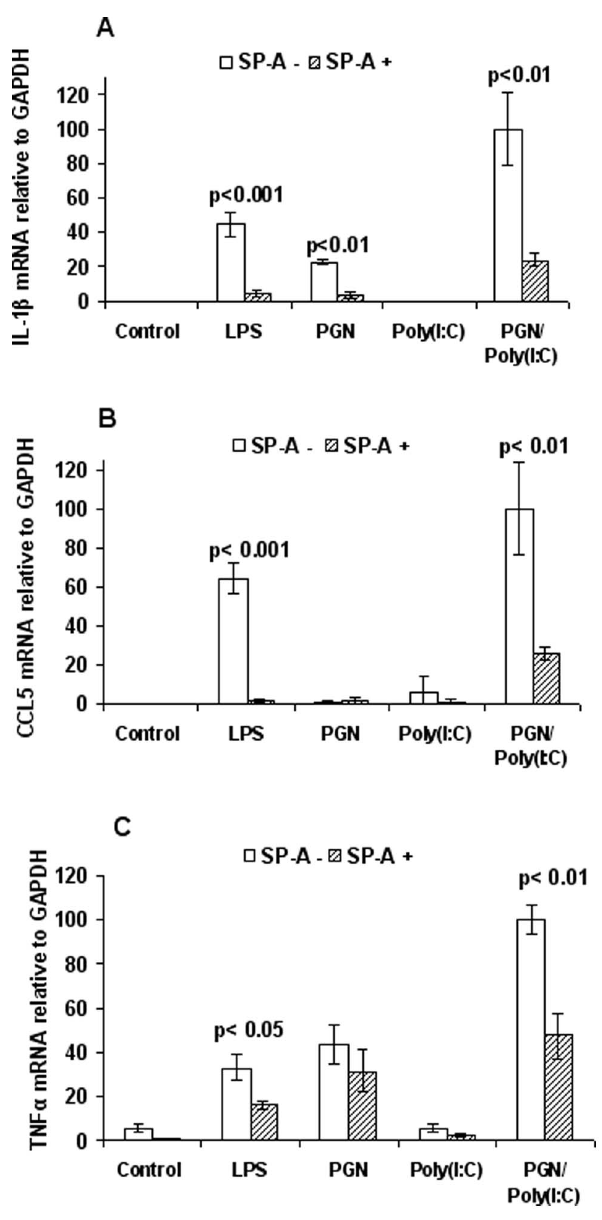
Figure 1. SP-A suppresses TLR ligand-induced expression of inflammatory mediators. Expression by RT-PCR of IL-1 b (A), CCL5 (B) and TNF- a (C) in the RAW 264.7 macrophage cell line 5 hours after treatment with PBS, LPS (a TLR4 ligand), PGN (a TLR2 ligand), poly (I:C) (a TLR3 ligand) and PGN + poly(I:C), with or without SP-A. Concentrations of reagents are provided in the text (Methods). P values were calculated by t-test and compare exposures with and without SP-A . n=3 replicates per condition per experiment. Depicted is a representative figure from three repeat experiments. Error bars=standard deviation. Values for PGN + Poly(I:C) group were set to